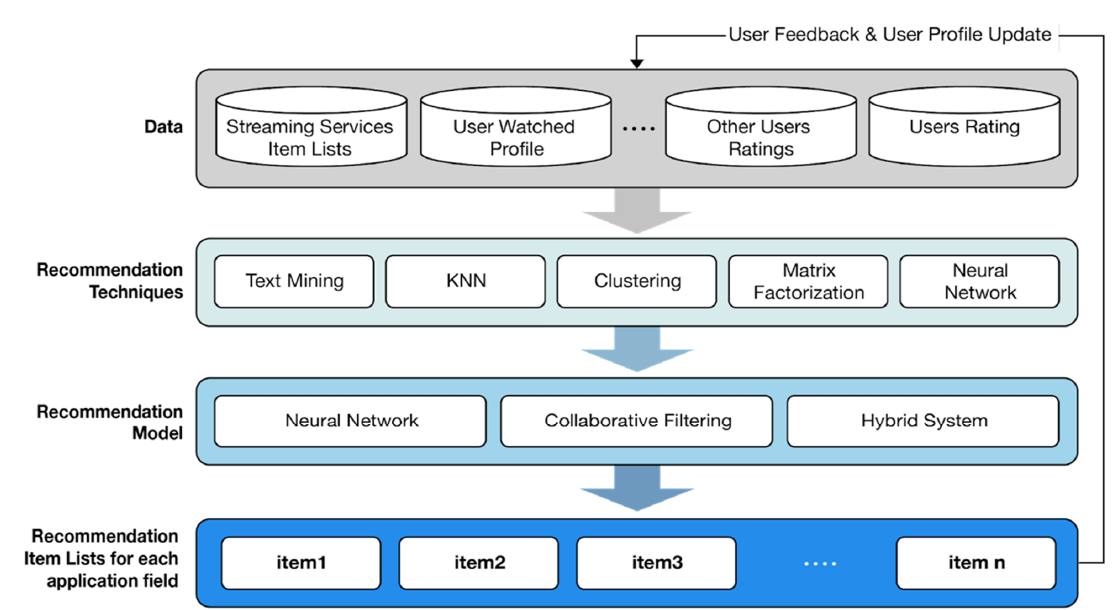
Figure 4. Overall flow of recommendation models and recommendation techniques.